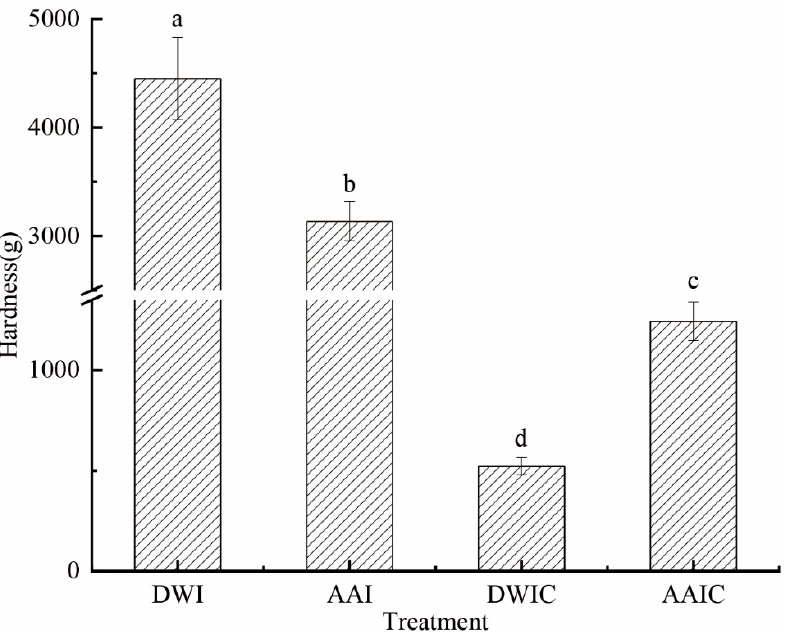
Figure 1. Hardness of arrowhead bulb slices under different treatments. DWI: distilled water immersion for 15 h; AAI: 0.6% acetic acid immersion for 15 h; DWIC: cooked DWI; AAIC: cooked AAI. Data were obtained from nine replicates. Different letters indicate significant differences ( p < 0.05). The error bar stands for standard deviation ( n = 9).